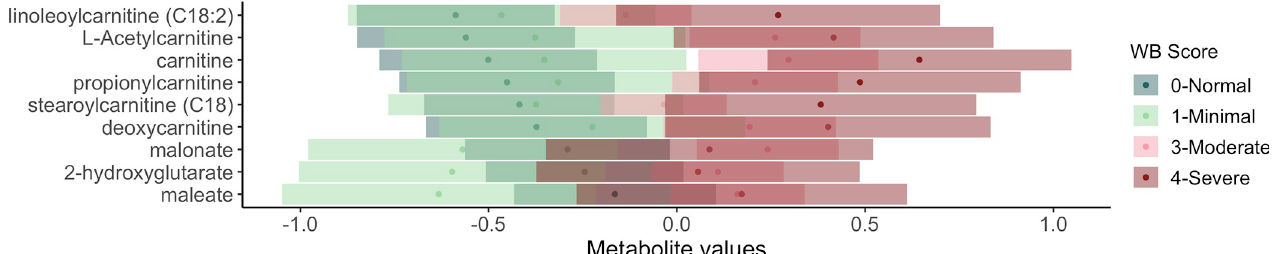
Fig 7. Association of wooden breast score with carnitine and fatty acid metabolism in plasma of male broiler chickens. Results of post-hoc analysis of metabolite values by wooden breast score are shown with estimated marginal means estimated marginal means (dots) and confidence intervals (bars). Overlapping confidence intervals indicate that there is no significant difference between the two scores. To improve visualization, metabolites are listed in order of the adjusted means for a wooden breast score of 0-Normal.